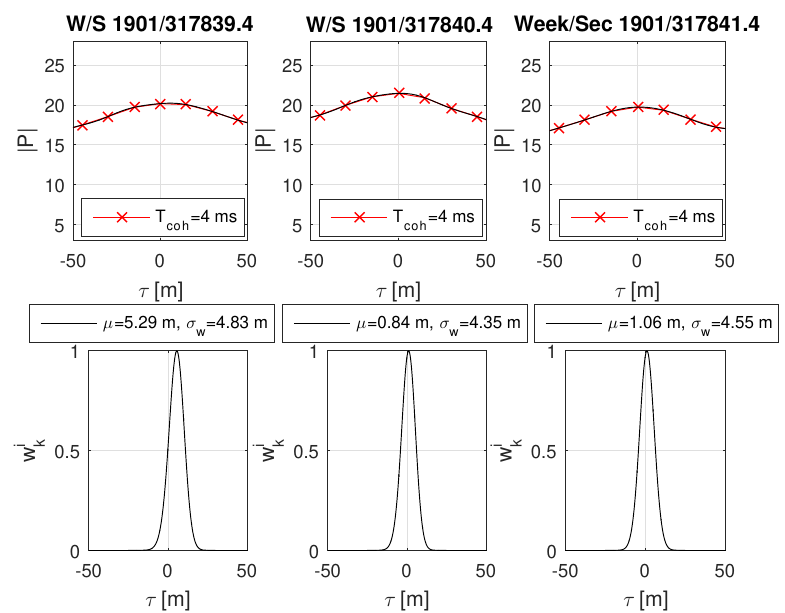
Figure 15. Real-world urban scenario of satellite GPS L1 C/A PRN 21. The plot content is analogical to Figure 14. For this satellite, it is assumed that the signal is less affected by the environment because there are fewer variations of the signal amplitude. Only in the case of the first position is the probability function biased.